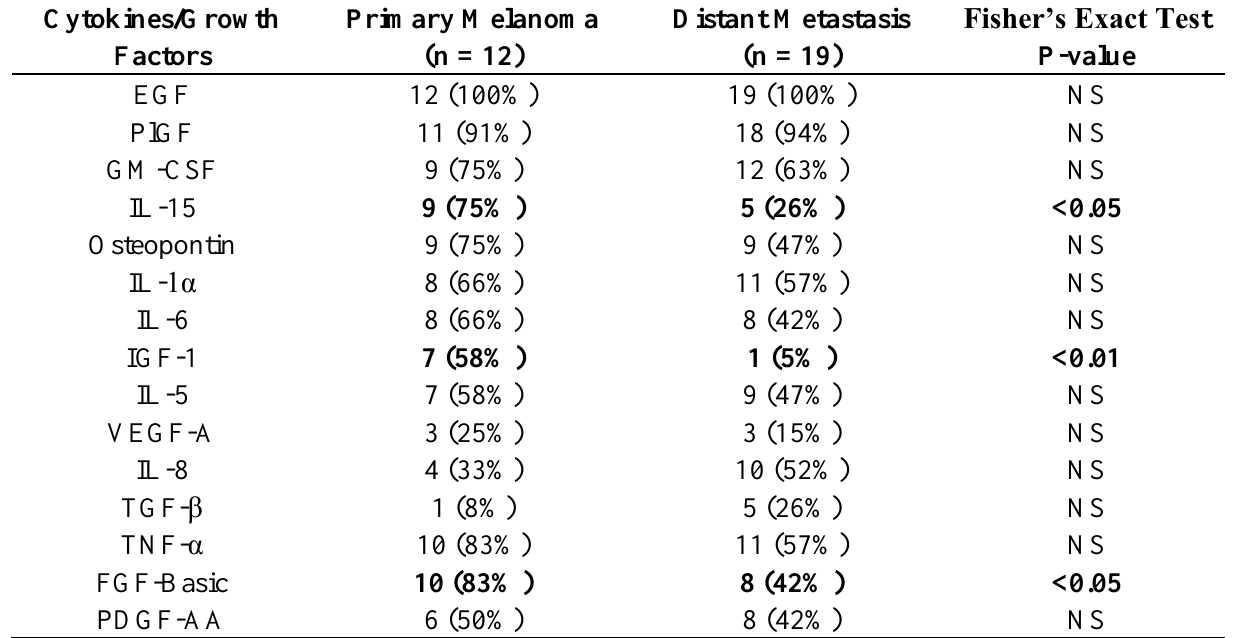
Table 5. Percent of melanoma cases over-expressing the cytokines/growth factors evaluated by the extent of immunohistochemical stained tumor